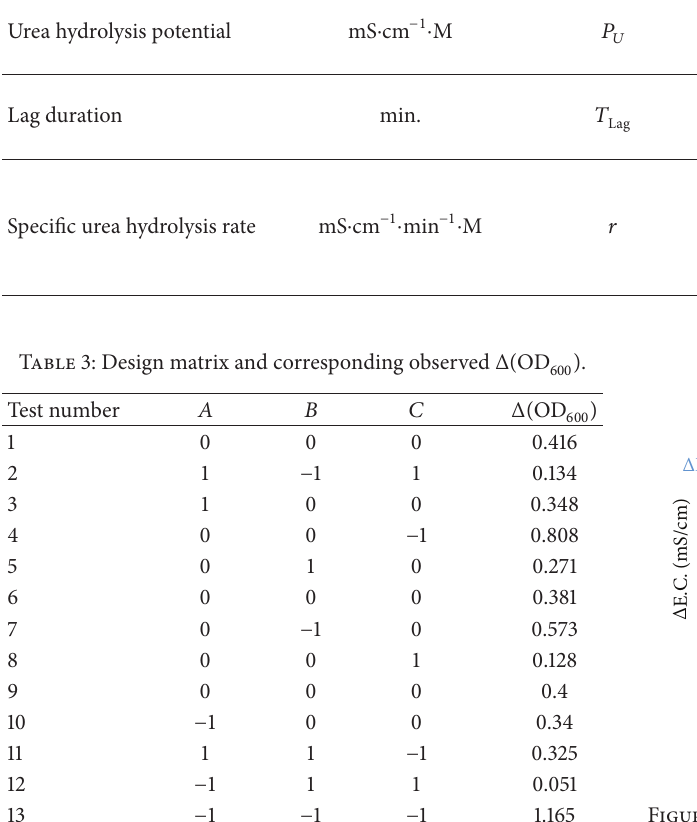
Figure 2: Graphically obtaining the urea hydrolysis potential, lag duration, and specific urea hydrolysis rate; for example, in the above curve which is related to test number 11 (see = 67.5 mS ⋅ cm −1 ; 𝑃 𝑈 = (Δ E.C. ) Table 3), (Δ E.C. ) max